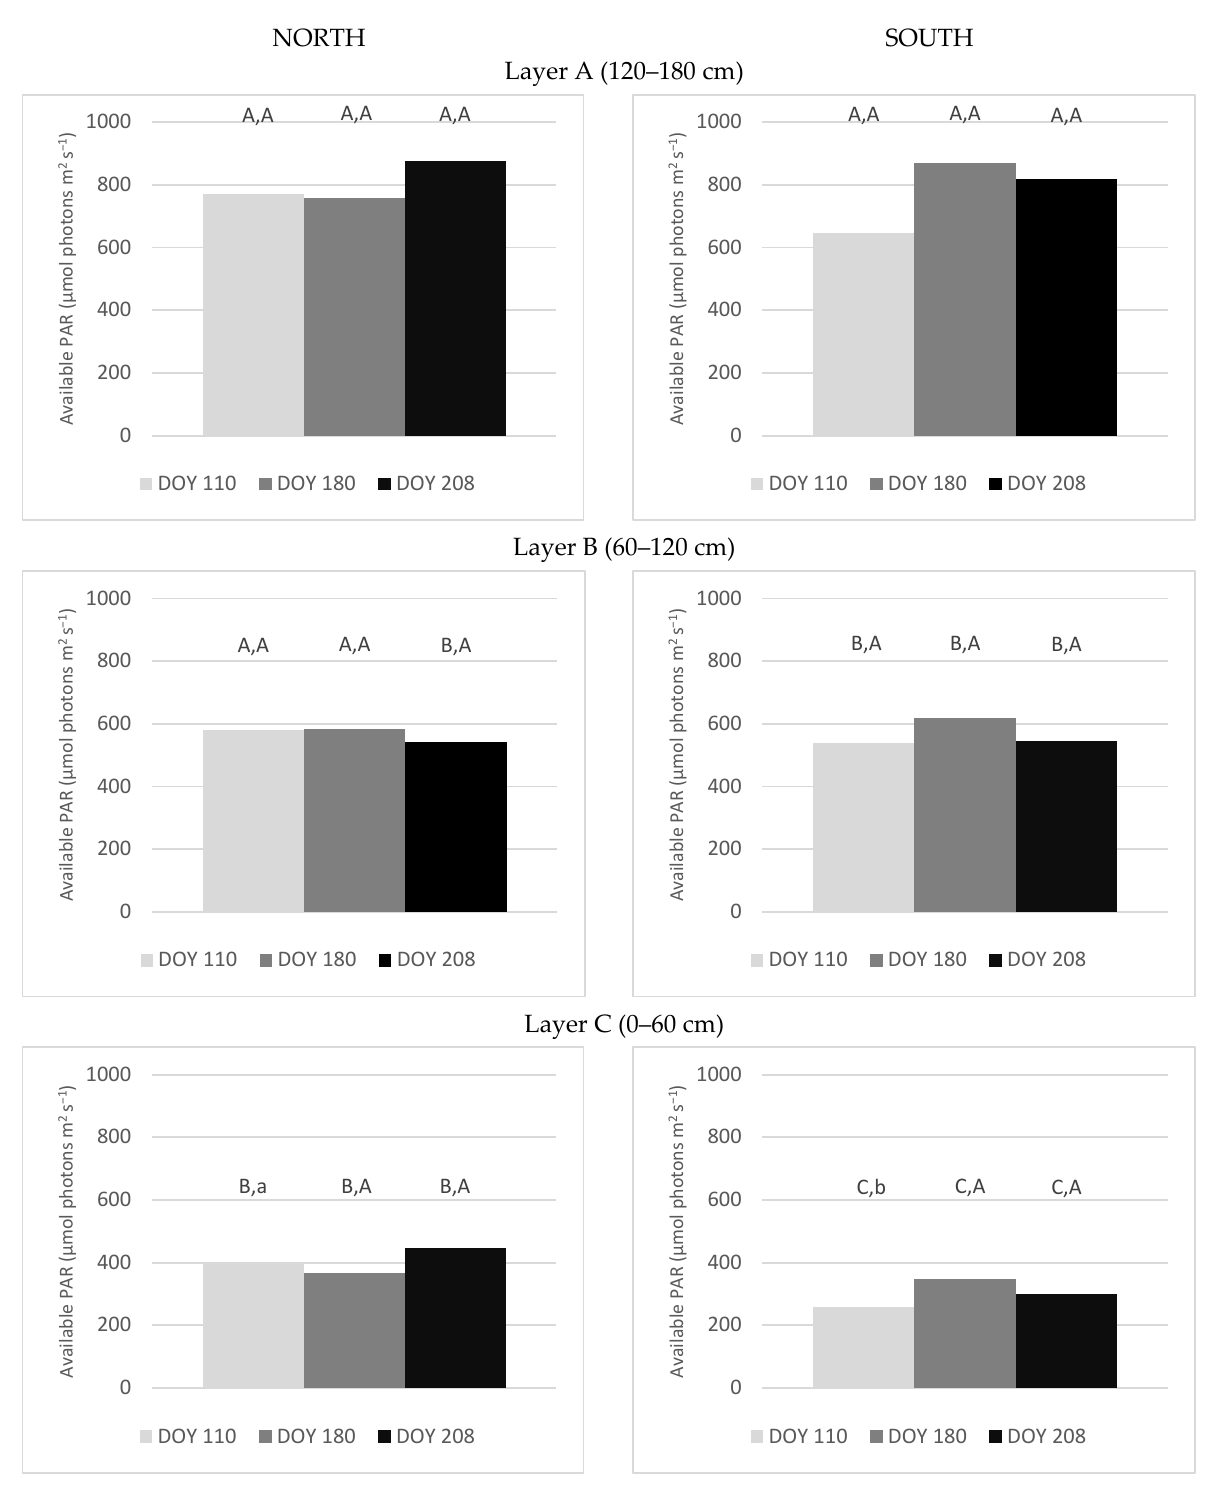
Figure 3. Available PAR ( µ mol photons m 2 s − 1 ) in layers (A, B and C) of orchard with east-west orientation (north and south exposures) on three DOYs. The first letter denotes significant differences between layers for a given exposure and DOY ( n = 45; p = 0.05/0.01; SNK test); the second letter denotes significant differences between exposure for a given layer and DOY ( n = 90; p = 0.05/0.01; SNK test). Lower case letters denote statistical differences with p = 0.05. Capital letters denote statistical differences with p = 0.01.